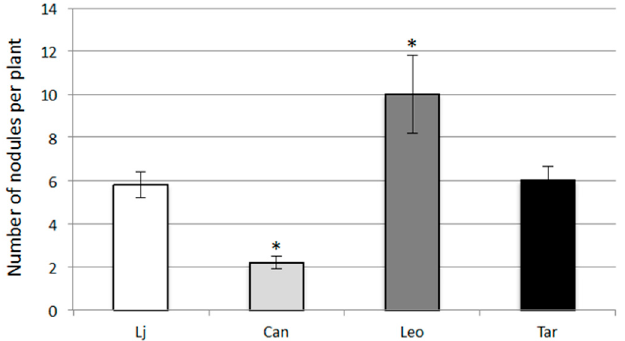
Figure 5. Nodulation capacities of L. japonicus (Lj) and L. corniculatus cvs. Canetra (Can), Leo and Targovishte 1 (Tar). The plants are grown after inoculation with M. loti for three weeks under N-free MS medium. Data bars represent means and SD of measures from three experiments (10 plants per experiment per condition). Data are scored 25 days after sowing (21 days after transferring the plants from H 2 O agar). Asterisks indicate significant differences with nodules scored on L. japonicus plants ( p < 0.05).